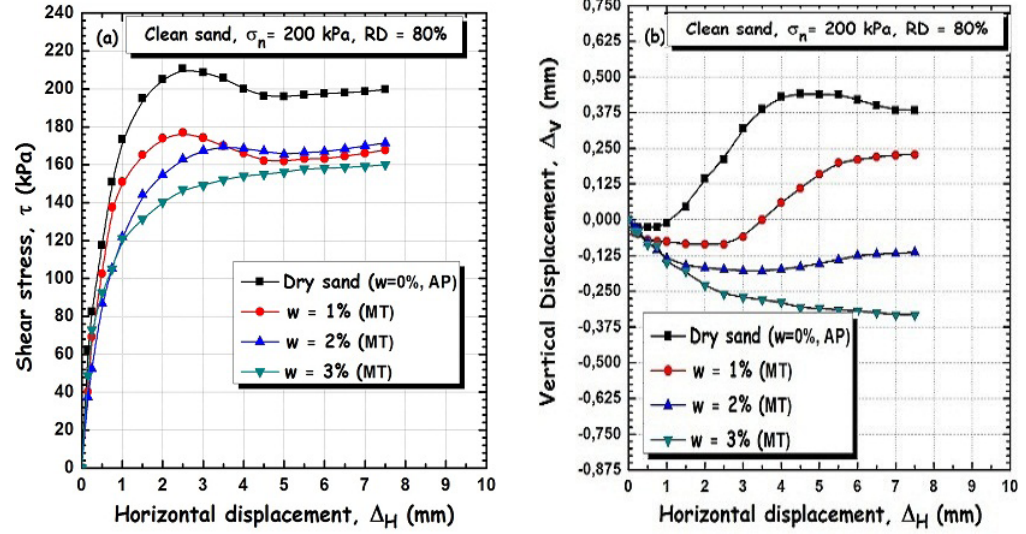
= 200 kPa): (a) variation of the shear strength n